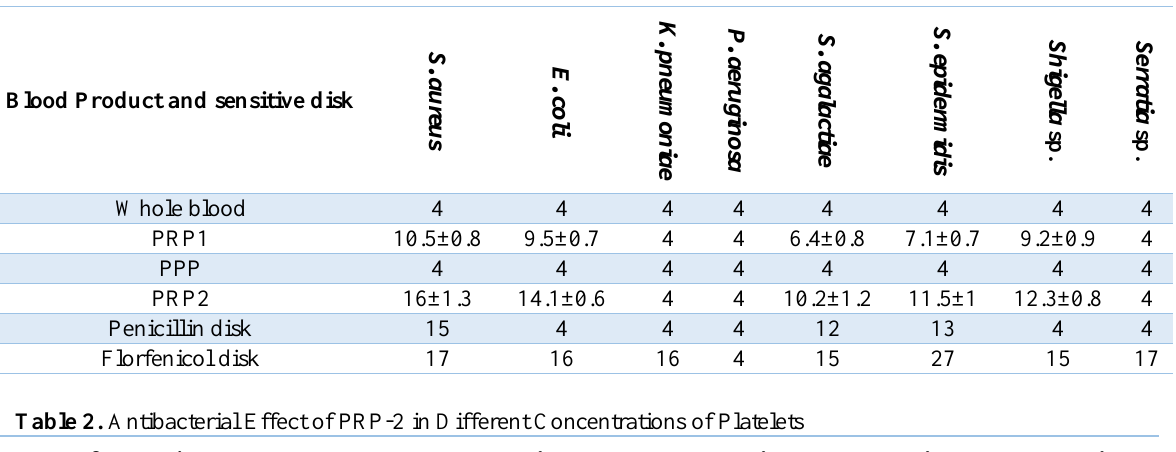
Table 1. Zones of Inhibition